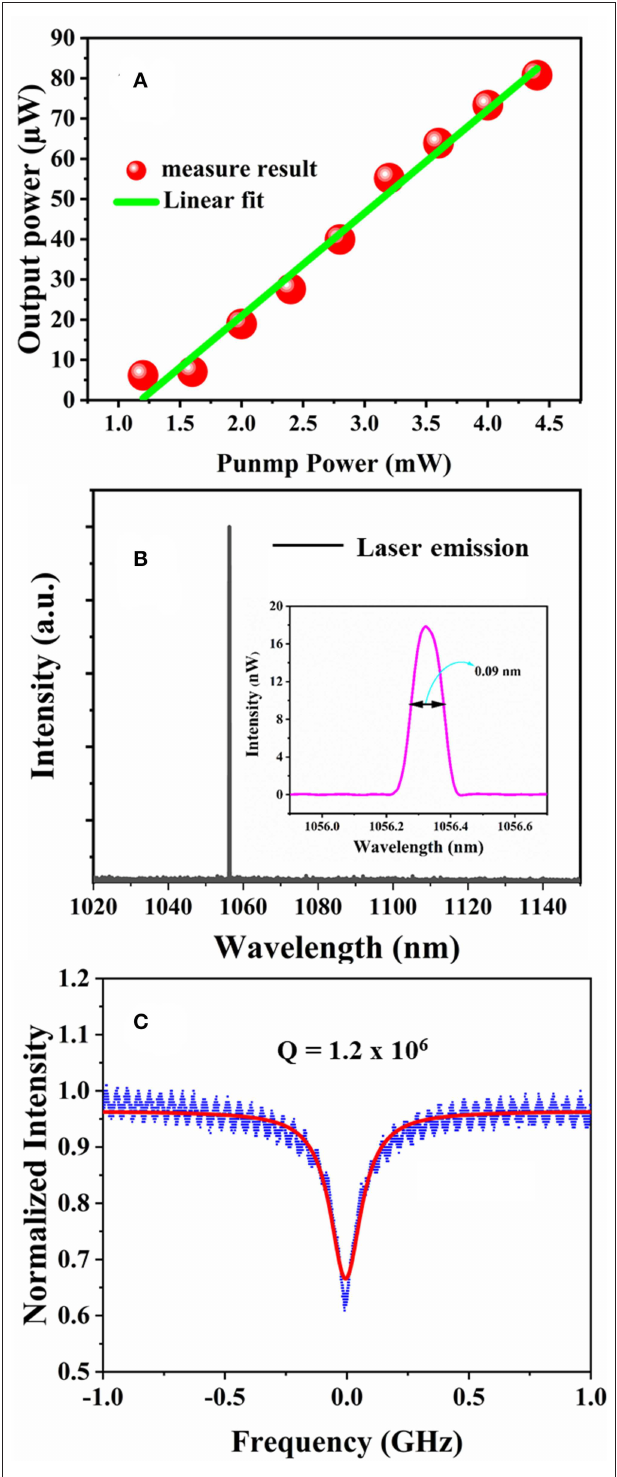
FIGURE 5 | (A) Relation between laser output power and pump power in the glass microsphere; (B) single mode laser emission from 0.8 mol% Nd3 ± doped fluorosilicate glass microsphere. Inset: zoom-in of the laser emission peak; (C) normalized transmission in the microsphere using 1,550nm tunable laser. The red line represents the Lorentz fitting.